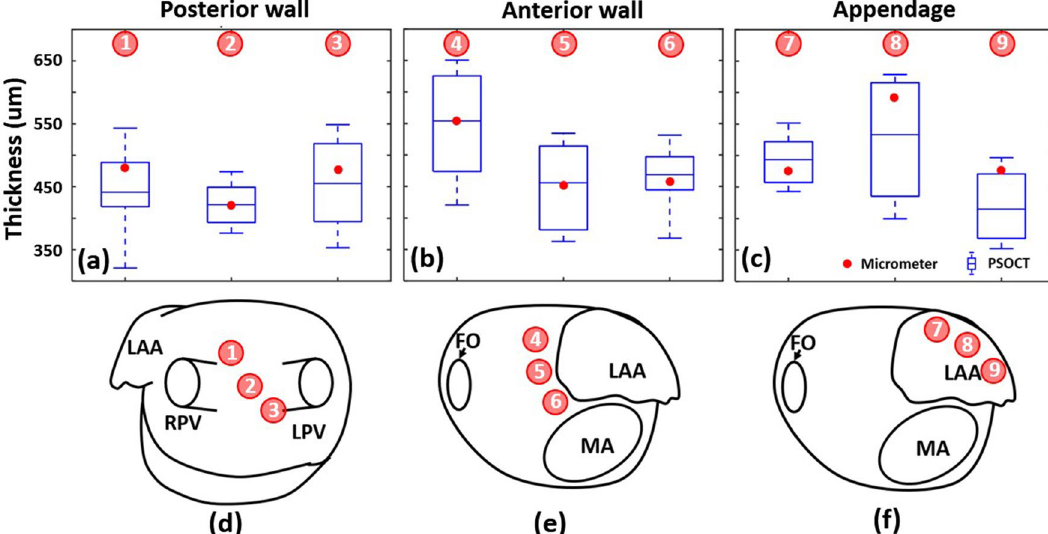
Figure 3. Cardiac LA wall thickness measurement validation. ( a – c ) are the comparison of wall thickness measured with PSOCT images (Whiskers, maximum and minimum; box, standard deviation; line, mean) and micrometer (red dots). ( d – f ) are maps of the anterior and posterior LA wall with locations noted for the wall thickness measurements. FO Foreman ovalis, LAA Left atrium appendage, MA Mitral annulus, RPV Right pulmonary vein, LPV Left pulmonary